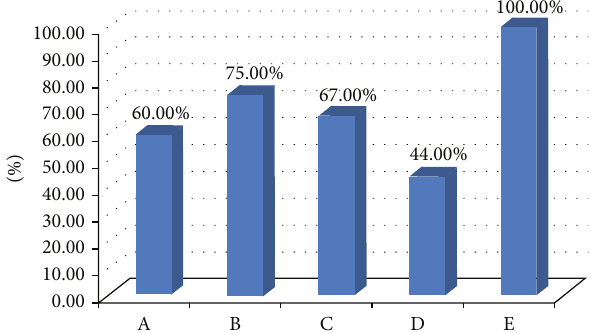
Figure 2: All gerbils in control group ( H. pylori given only) showed positive result of H. pylori test in 52th week. Lower positive rates were noted in those yogurt-fed groups. Group D reveals lowest positive rate. It demonstrated that yogurt can prevent H. pylori infection and the effect might be related with the duration of yogurt